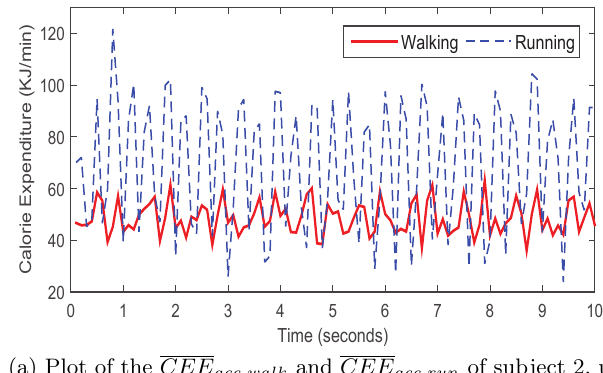
(a) Plot of the CEE acc walk and CEE acc run of subject 2, using the regression model given in Equation (1)